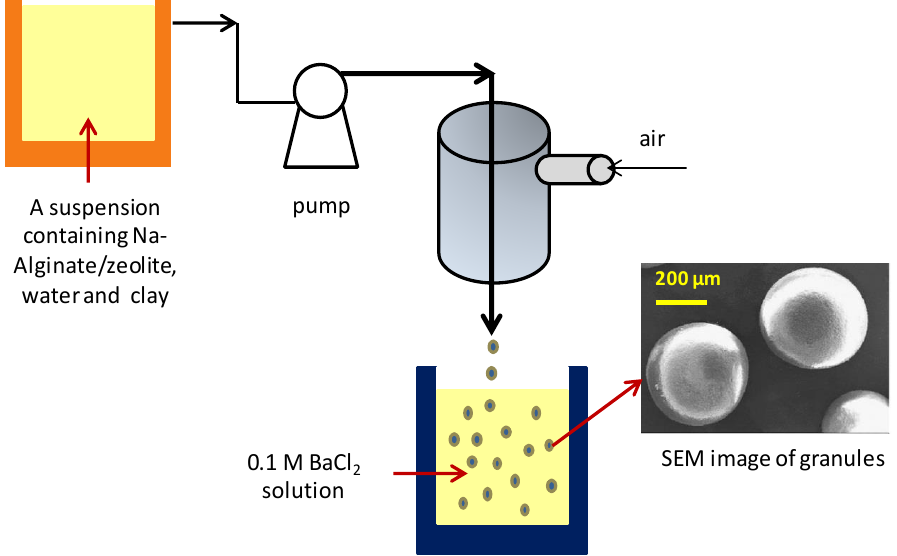
Figure 5. Schematic representation of synthesis granular and binder-free zeolite Y [91].